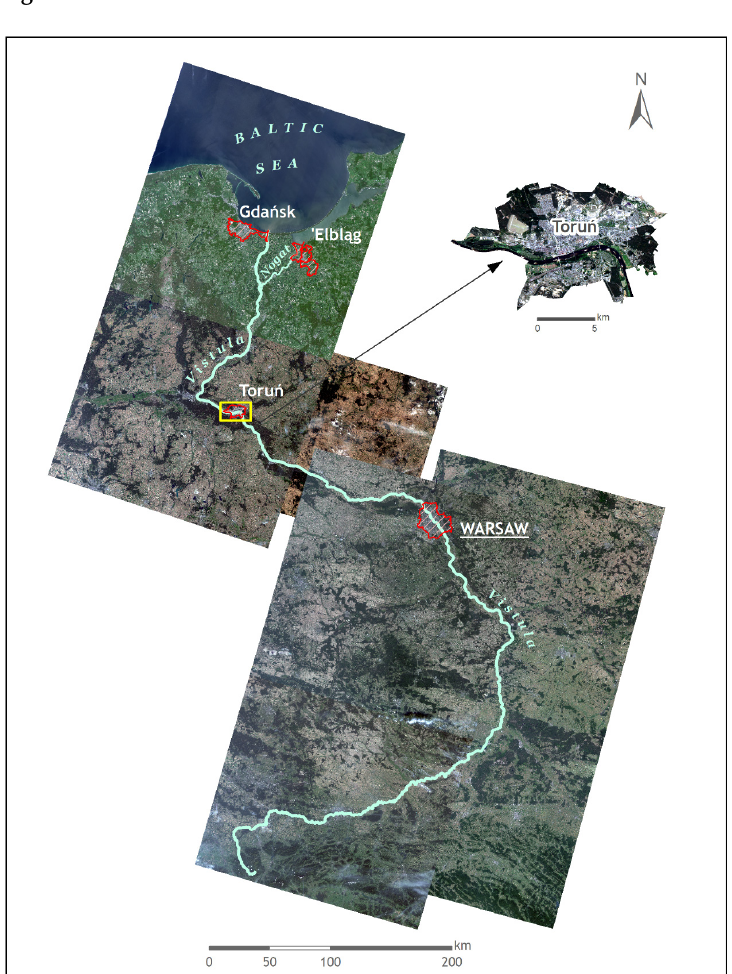
Figure 1. Poland and Vistula River.